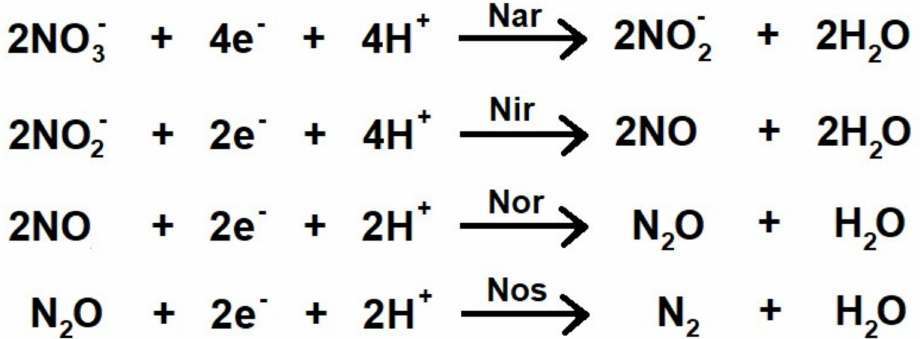
Figure 1. Summary of the four key reactions involved in denitrification (adapted from [4]). Nar: Respiratory nitrate reductase (EC 1.7.5.1); Nir: Respiratory nitrite reductase (EC 1.7.2.1); Nor: Respiratory nitric oxide reductase (EC 1.7.2.5); Nos: Respiratory nitrous oxide reductase (EC